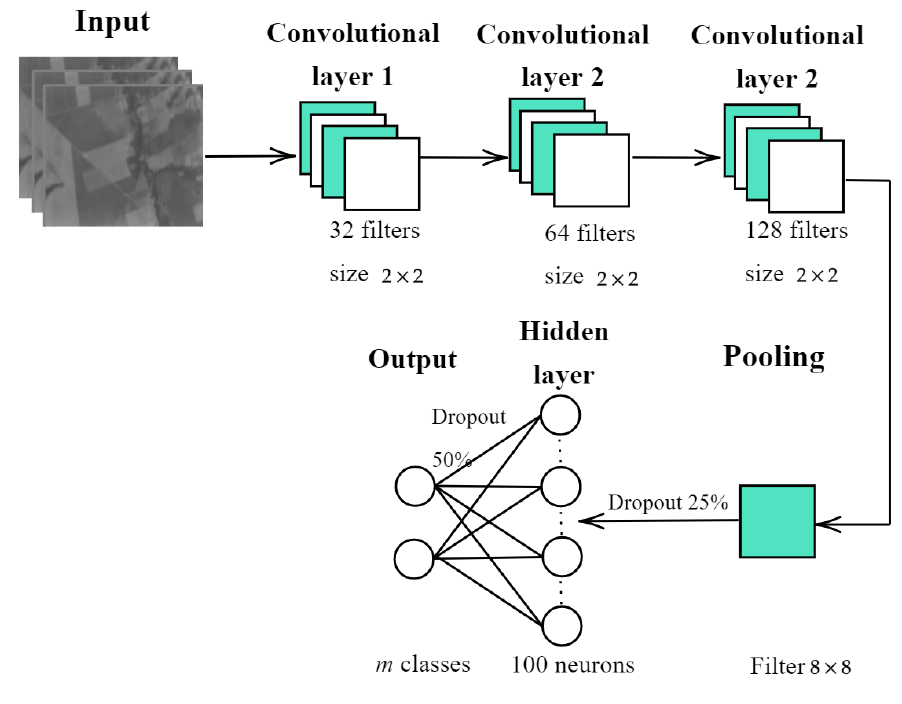
Figure 4. A schematic view of the proposed 2D-CNN 1. On the other hand, the 2D-CNN 2 is composed of three convolutional layers, each of which is followed by a max-pooling of 2 × 2. In this architecture, a 1 × 1 convolutional layer is applied in order to extract more features of the images without losing information. Then, dropout layers are applied to deactivate a percentage of the neurons and prevent overfitting. Figure 5 shows an explaining diagram of the architecture 2D-CNN 2.